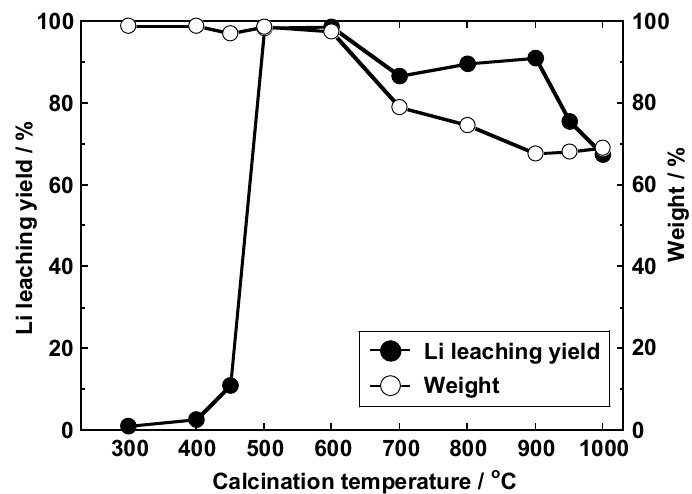
Figure 4. Variation of the lithium leaching yield and sample weight of the cathode model samples with the calcination temperature.